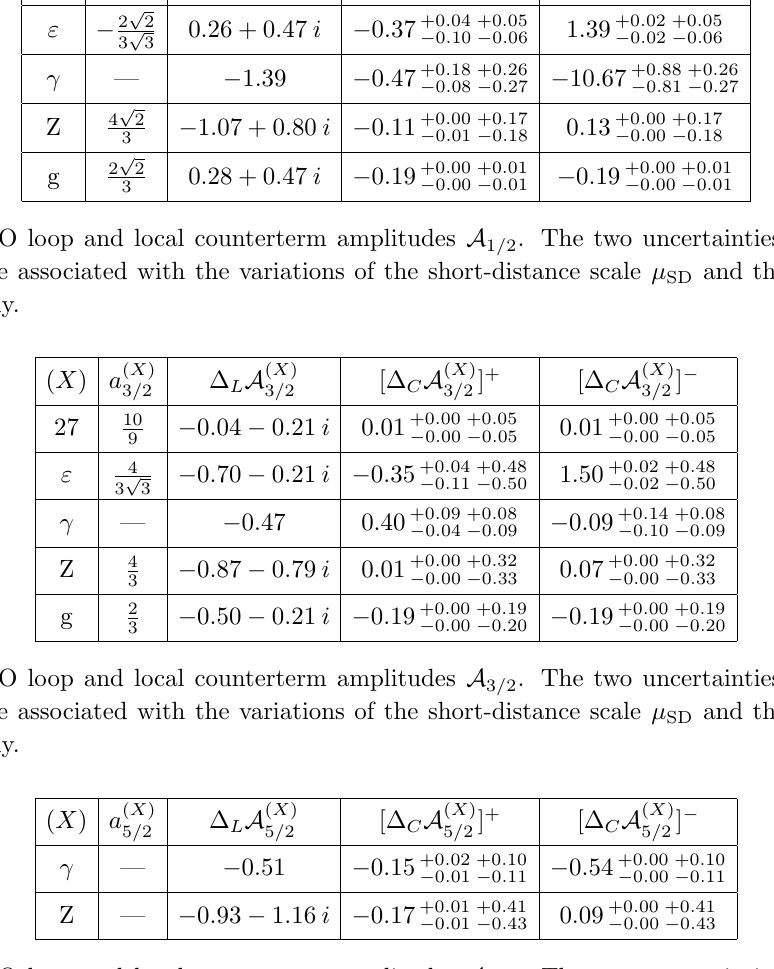
Table 6 . NLO loop and local counterterm amplitudes A amplitudes are associated with the variations of the short-distance scale (cid:22) SD and the chiral scale (cid:23) (cid:31) ,